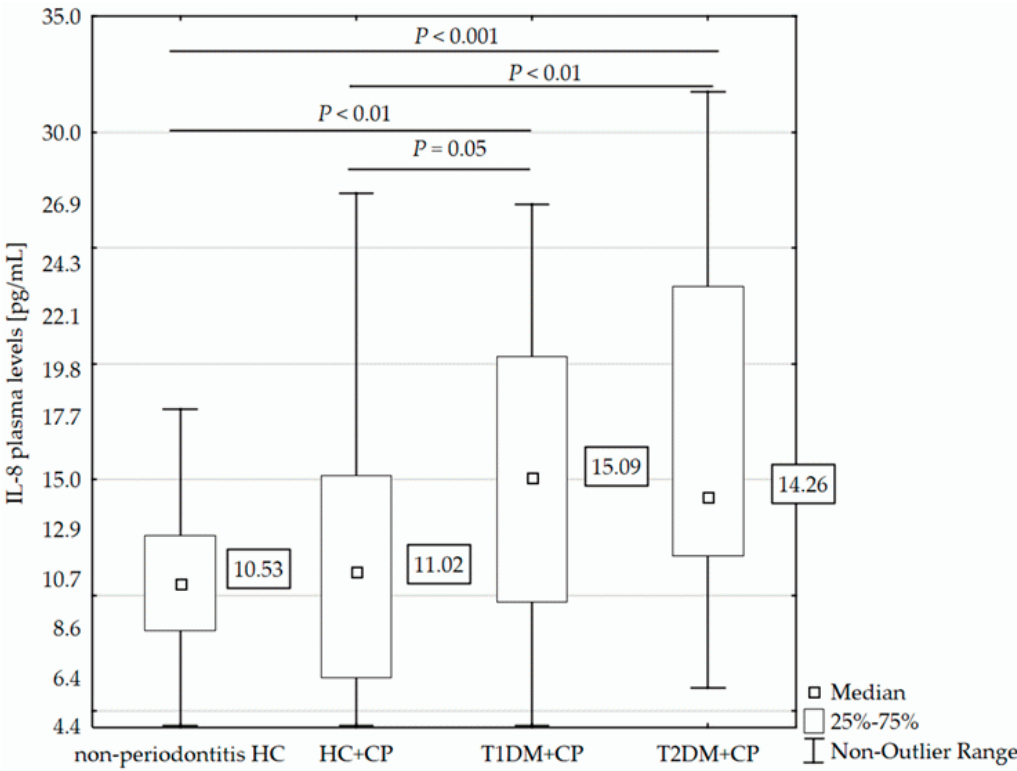
Figure 1. Comparison of IL-8 plasma levels in T1DM+CP ( N = 36) and T2DM+CP patients ( N = 44) and HC+CP ( N = 41) and non-periodontitis HC ( N = 32). Samples with IL-8 levels under the limit of detection (<4.40 pg/mL) were assigned a value of 4.39 pg/mL. The Mann-Whitney U-test (two-tail) was used for the calculation of significant differences.